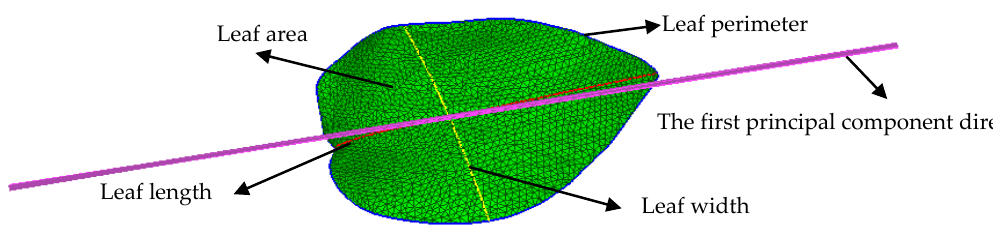
Figure 3. Visualization of four scale-related morphological traits (leaf area, perimeter, length, and width) on the 3D-triangle mesh of a leaf.